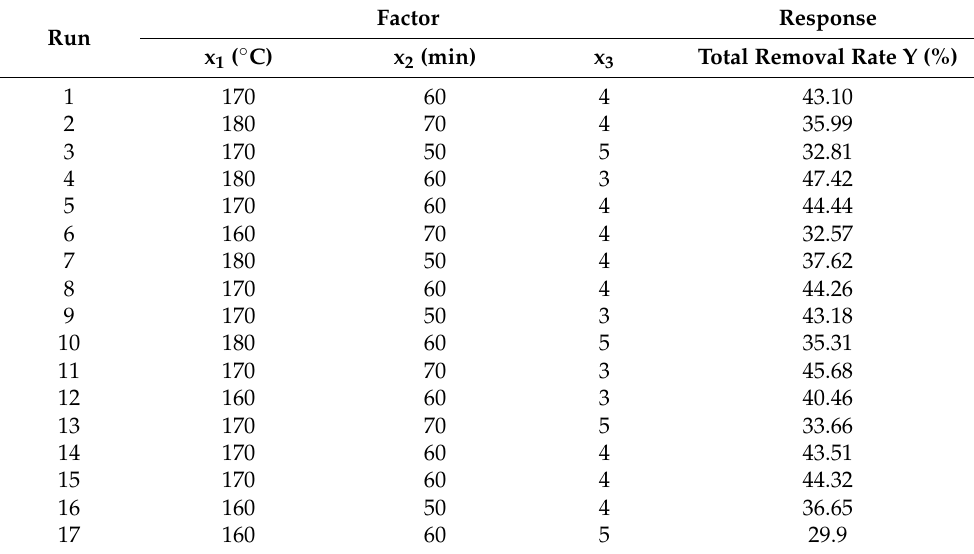
Table 2. Response surface experiment design and